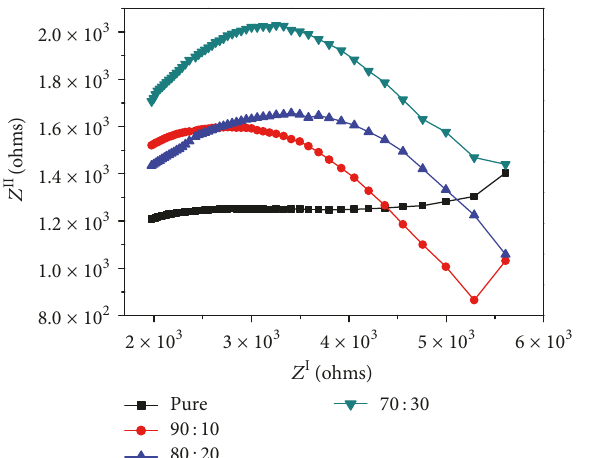
Figure 6: Cole-Cole plots for different wt% ratios of composite polymer electrolyte films.